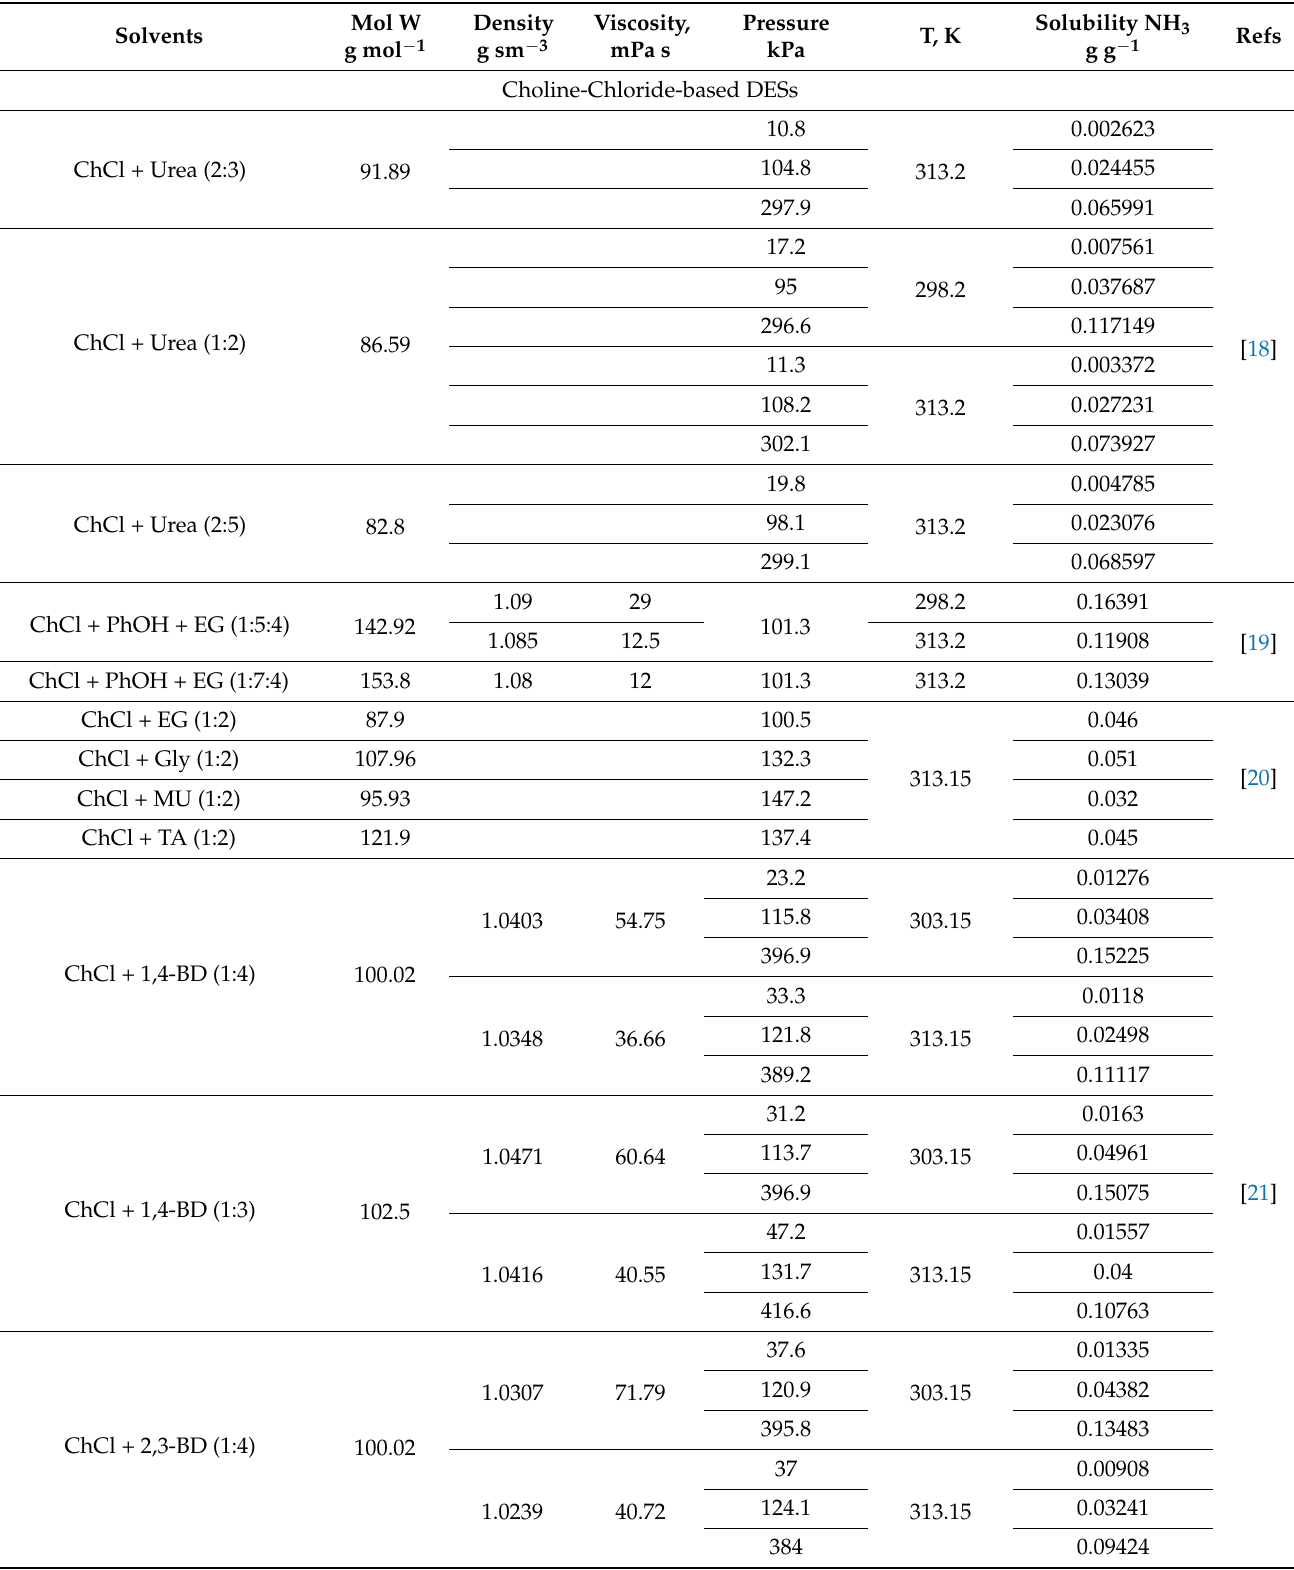
Table 1. Comparison of different NH 3